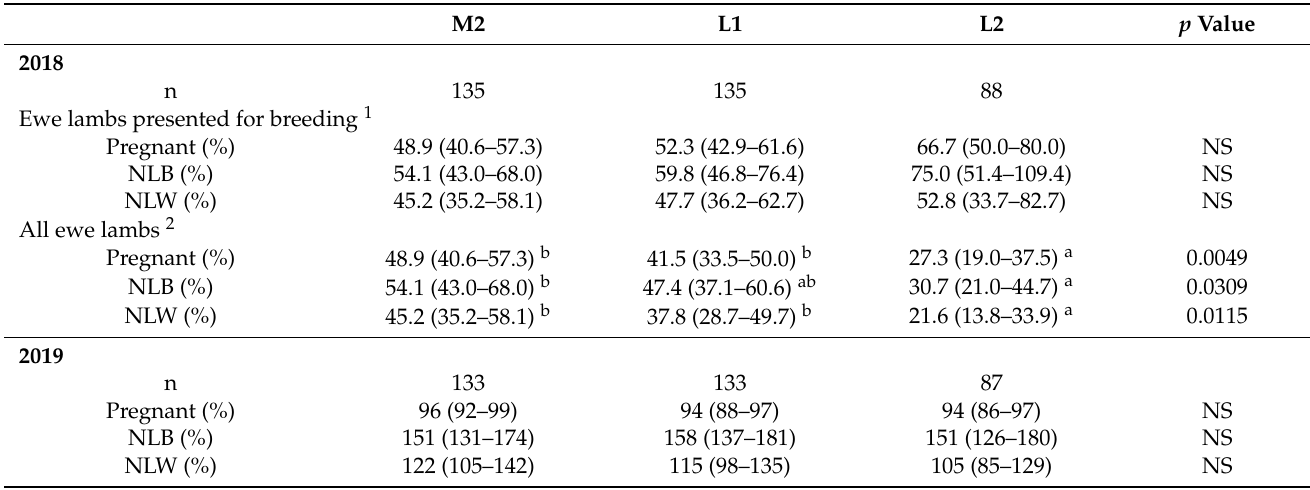
Table 2. Number of ewe lambs diagnosed as pregnant, and number of lambs born (NLB) and weaned (NLW) per ewe lamb presented for breeding in 2018, or per ewe lamb in the entire study population in 2018 and 2019, for ewe lambs born to mature ewes as twins (M2), born to ewe lambs as singletons (L1) or as twins (L2). Values are back-transformed LS means and 95% confidence